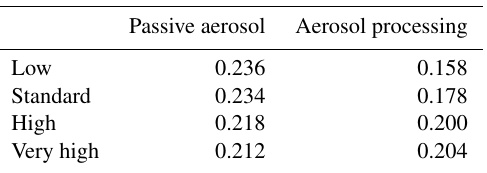
Table 3. Precipitation efficiency (PE) of the different simulations. PE is defined as the ratio of domain-integrated precipitation to domain-integrated condensate gain. Passive aerosol Aerosol processing Low 0.236 0.158 Standard 0.234